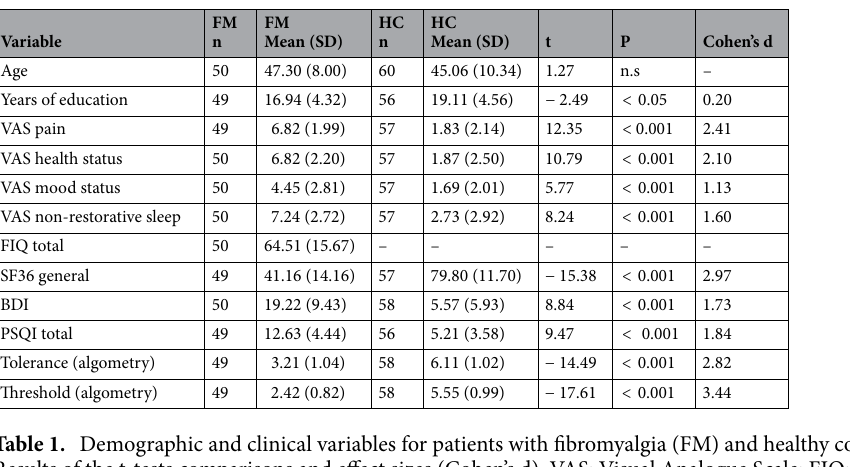
Table 1. Demographic and clinical variables for patients with fibromyalgia (FM) and healthy controls (HC). Results of the t-tests comparisons and effect sizes (Cohen’s d). VAS: Visual Analogue Scale; FIQ: Fibromyalgia Impact Questionnaire; BDI: Beck Depression Inventory; PSQI: Pittsburgh Sleep Quality Index; n.s.: non-